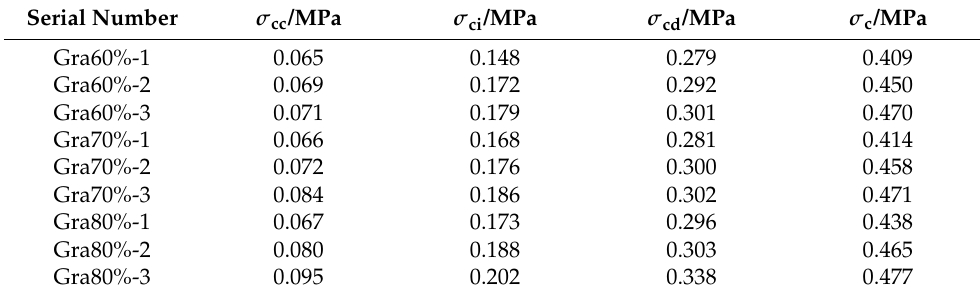
Figure 11. Volumetric strain of cracks under 80% of the UCS: ( a ) Gra80% − 1; ( b ) Gra80% − 2; ( c ) Gra80% − 3. Table 4. Values of characteristic stresses of rock specimens.